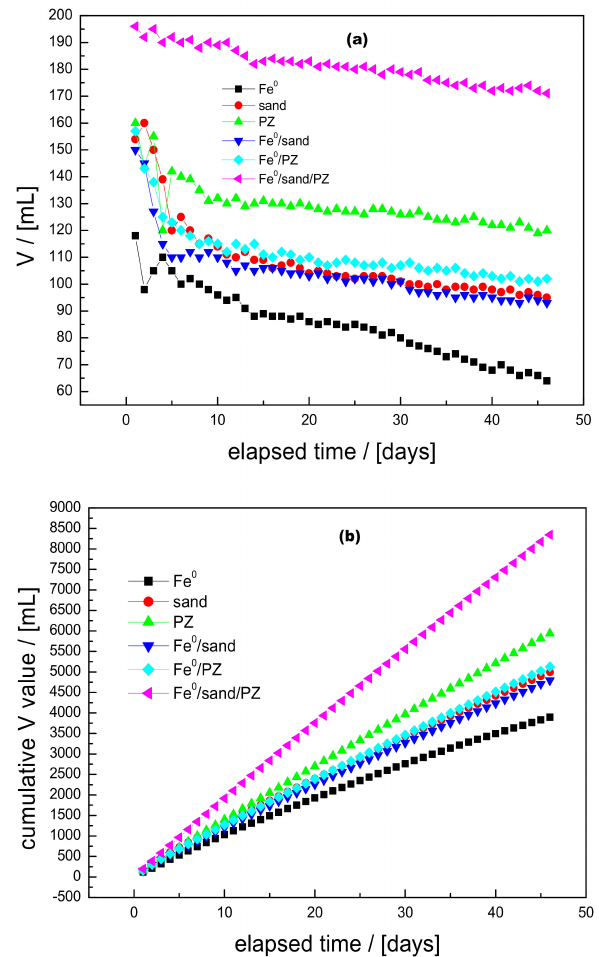
Figure 3. Time-dependent changes in effluent ( a ) volume and ( b ) cumulative volume for the 6 investigated systems. Experimental conditions: 6 g Fe 0 ; [MB] = 2.0 mg · L − 1 . Filling materials: